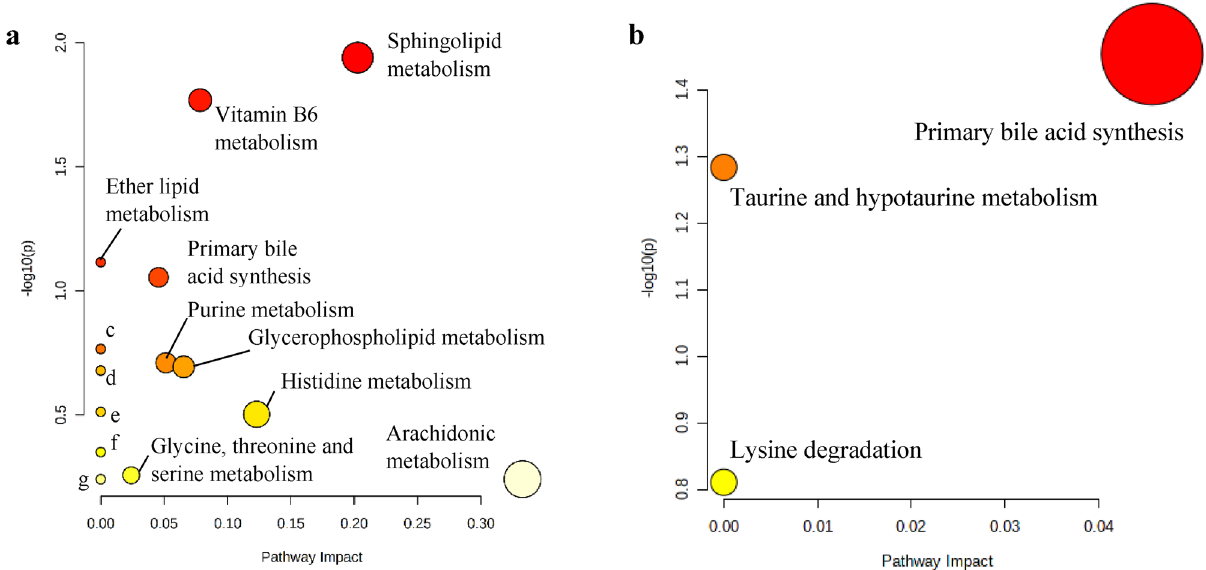
Figure 2. Biochemical pathways identified in TRF and ETRF against HFD ( a ) and ETRF against TRF ( b ) using MetaboAnalyst. Analysis of the metabolites profiled in TRF and ETRF against HFD generated 15 biochemical pathways while the metabolites profiled in ETRF against TRF derived three biochemical pathways that were altered. c: taurine and hypotaurine metabolism; d: biotin metabolism; e: aminoacyl-tRNA metabolism; f: lysine degradation; g: biosynthesis of unsaturated fatty acids.